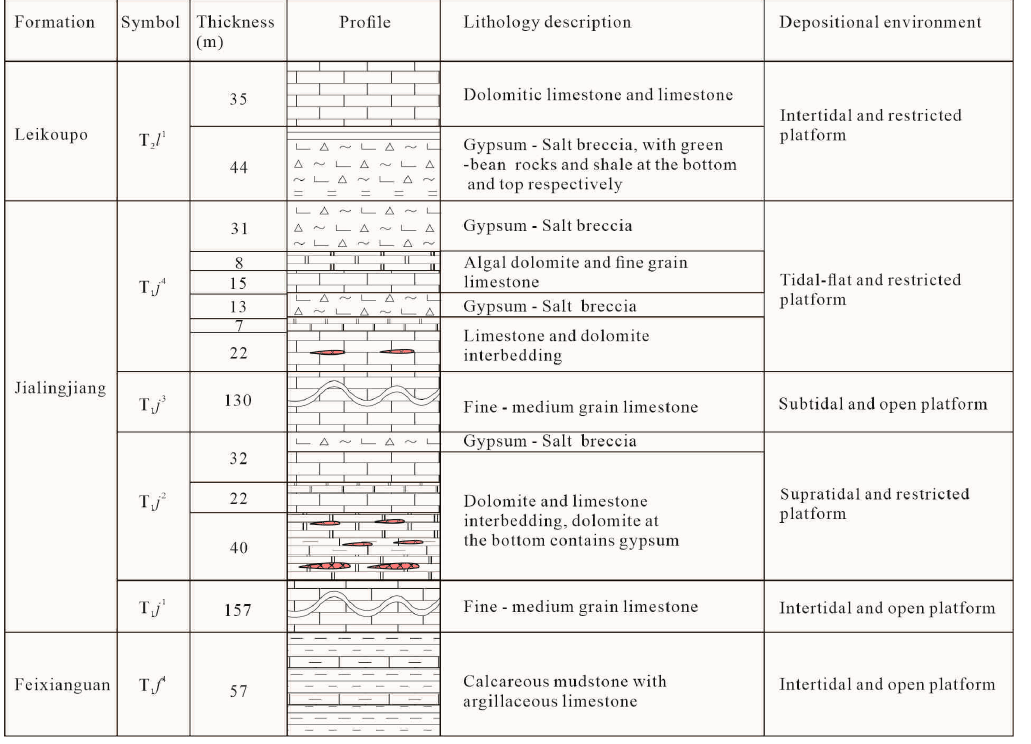
Figure 4. Synthetic stratigraphy for the fold belt in the east of the Sichuan basin (red symbols repre- sent ore bodies).